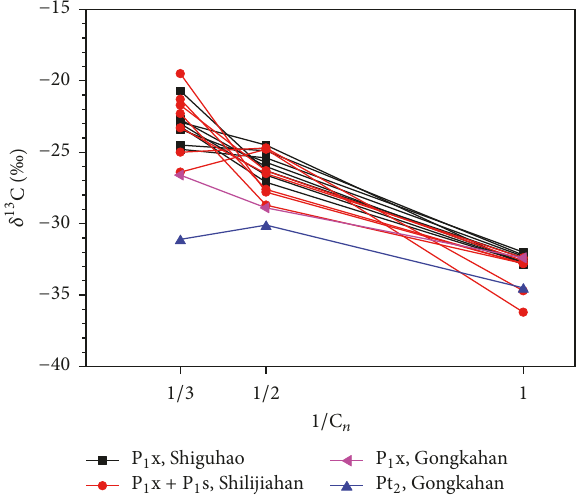
Figure 3: Correlation diagrams of dryness coefficient (C 1 /C 1 the Hangjinqi area in the Ordos Basin.